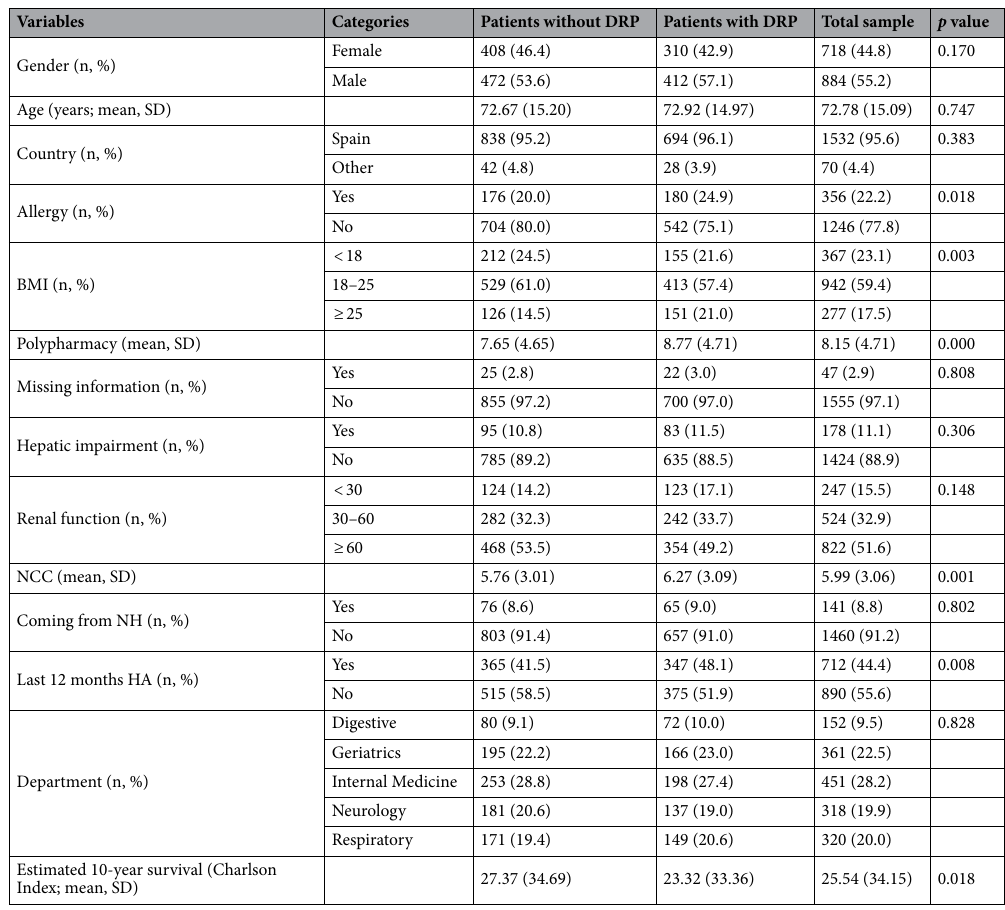
Table 1. Description of the sample. Frequencies, proportions, means and SDs are displayed. χ 2 Test (for 2 × N tables) and t-test (for continuous variables) were performed to compare across the presence of DRP. Missing information: lack of data regarding chronic treatment in clinical records. BMI body mass index, CI